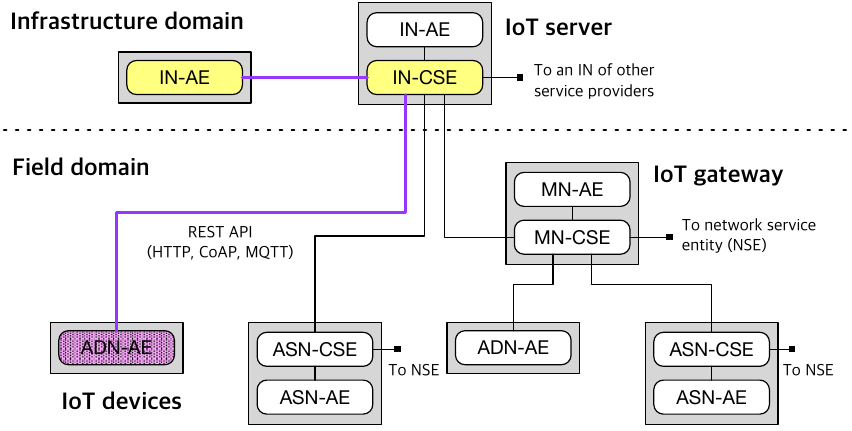
Figure 1. The oneM2M reference